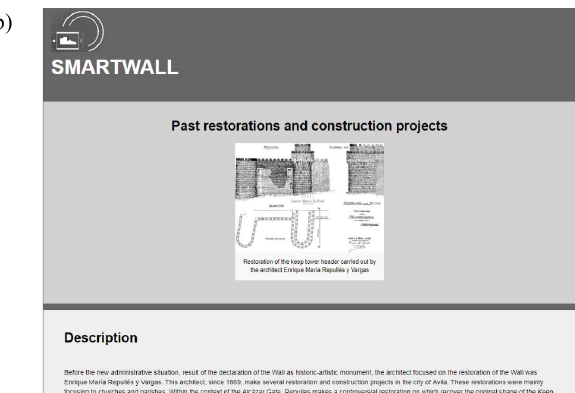
Figure 7. Interface of the platform SmartWall when an expert user interacts with it for: a) making a query to the database to filter the damages of the Wall by class of damage; b) and c) consulting the restoration works carried out by the architect Enrique Mª Repullés y Vargas on the Alcázar Gate. The link to the 4D viewer included within the modal page of the restoration action consulted, allows to evaluate the header of the homage tower before the intervention and deduce the criteria, as well as the restoration theory, followed by the architect (Figure 8).